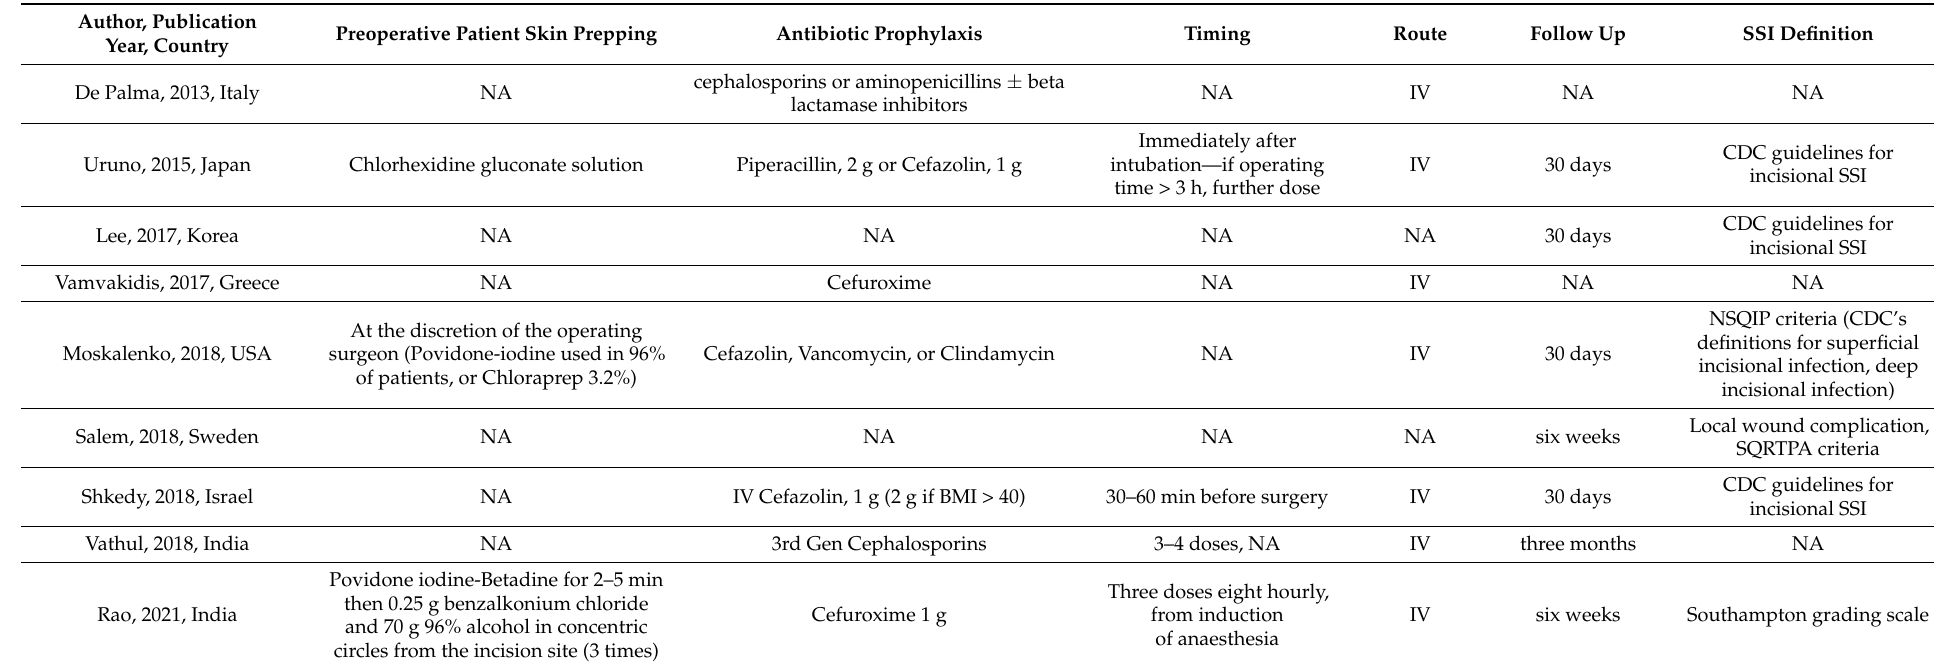
Table 2. Characteristics of antibiotic prophylaxis, definition of SSI and follow-up